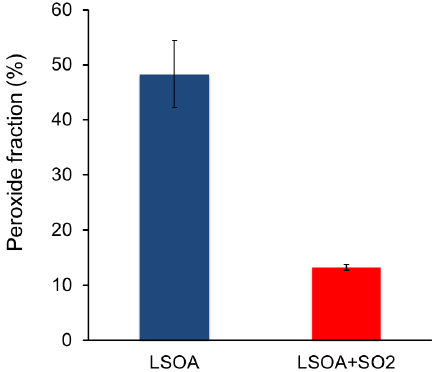
Figure 4. Mass fraction of peroxides in LSOA formed in the pres- ence and absence of SO 2 . Error bars represent measurements of three LSOA and three LSOA + SO 2 filters collected from different experiments. The peroxide measurement for each filter was repeated two